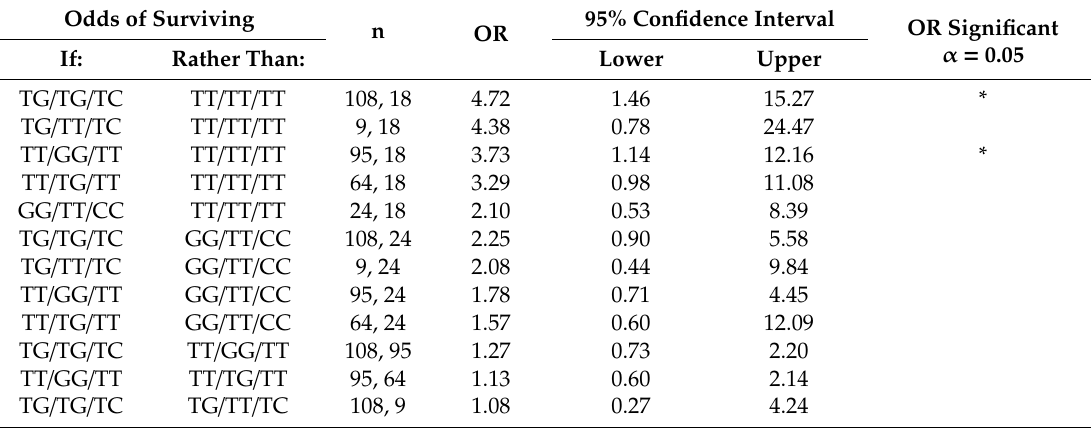
Table 2. Odds ratio comparisons of genotypes of Aedes aegypti (n = 322) from field and laboratory colonies (permethrin bioassay results combined). Odds ratio (OR) of surviving 0.25% permethrin with a specific genotype (order of mutation sites 1016 / 1534 / 989) (n = number of each genotype) are presented. Odds of Surviving n